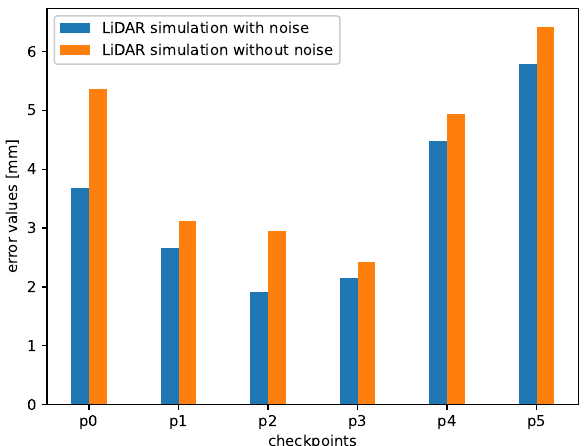
Figure 9. Mean error values between points from real and simulated point clouds.